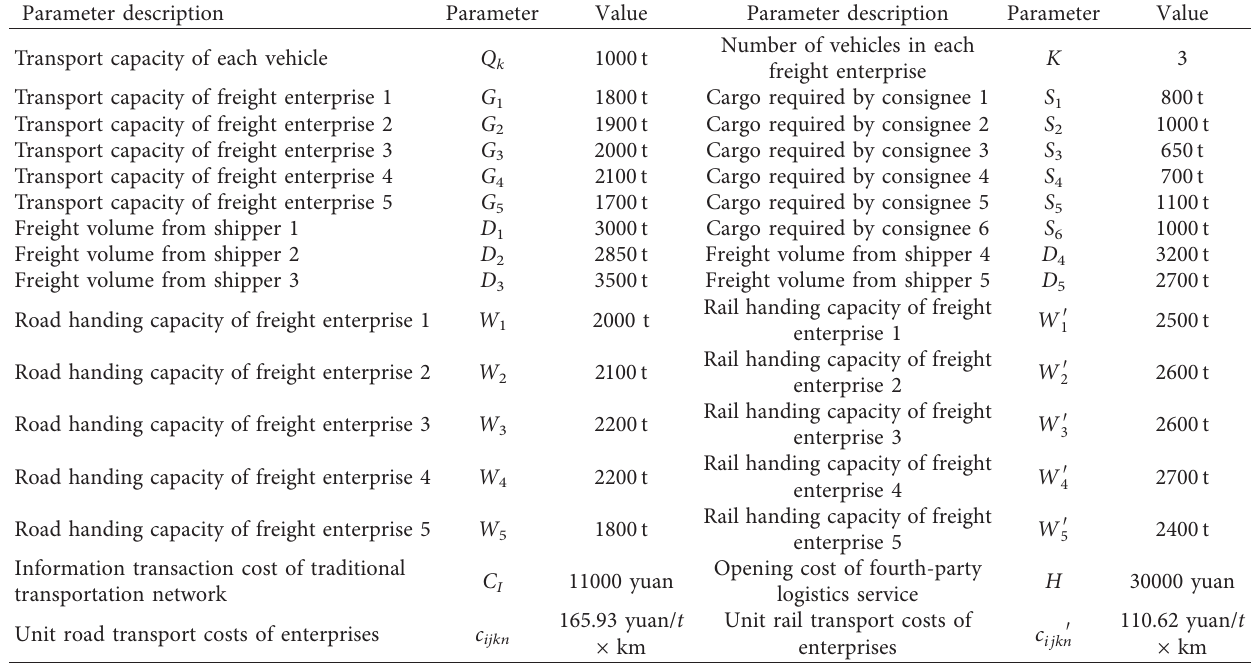
Table 9: Parameter of the large bulk cargo transport network.